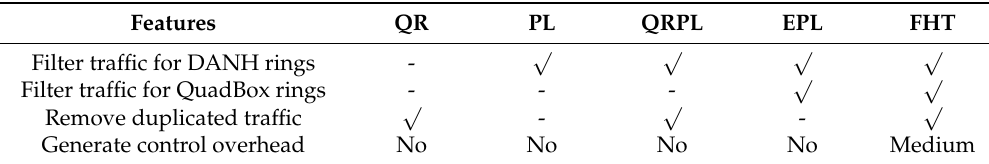
Table 1. Characteristics of traffic filtering